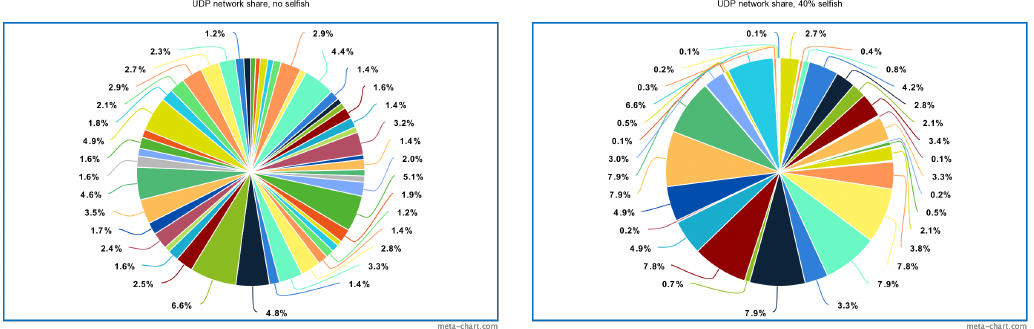
Figure 5. Network share of received packets at the AP for 50 stations divided in two RAW slots for 60 s.